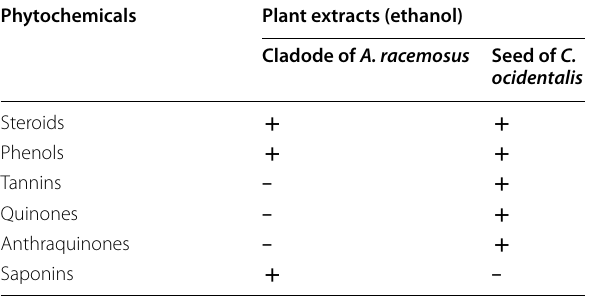
Table 1 Phytochemical analysis of alcoholic extracts from the cladode of A. racemosus and the seed of C.